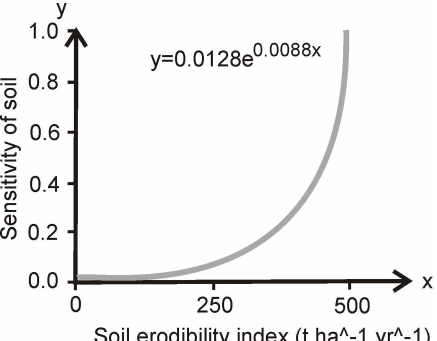
Figure 8. The applied linear fuzzy membership function of the re- lation between the frequency of erosive winds and the sensitivity to wind erosion. To define the frequency of erosive winds, days with a maximum wind speed above 9ms − 1 were used.